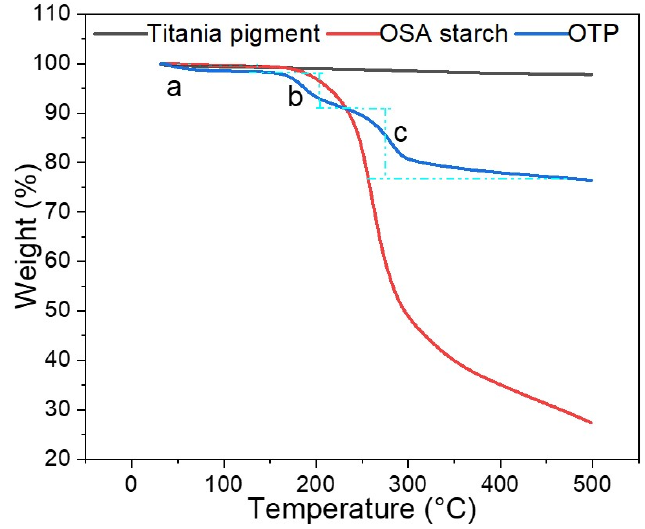
Figure 3. Thermogravimetric analysis (TGA) of titania pigment, OSA starch and OTP. The calorimetric thermograms of OTP was depicted as a graph of heat flow (W/g) versus temperature (°C) and shown in Figure 4. The onset temperature, glass transition temperature (T g ), and offset temperature were around 47 °C, 100 °C and 156 °C, respec- tively [35]. Generally, the onset temperature was accepted as melting temperature at which OTP particle started to change its physical form at 47 °C. This was attributed to the chain unfolding or re-arrangement of the OSA starch layer. At 100 °C, OTP reached the glass transition temperature, indicating that the starch coated on titania started to transform from glass state to a higher elastic state until 156 °C. Below 47 °C, OTP was remained in a stable shape, whereas its quality was seriously damaged after 100 °C.